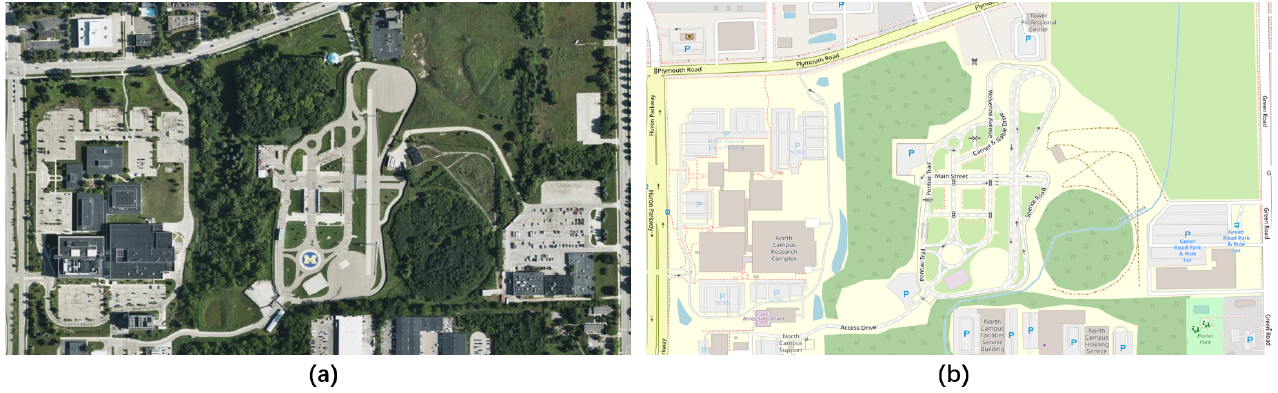
Figure 8. ( a ) Remote sensing images; ( b ) OpenStreetMap maps. Classification-based methods usually use geometric, photometric, and textural fea- tures of roads. Classification-based methods can be classified as supervised and unsuper- vised